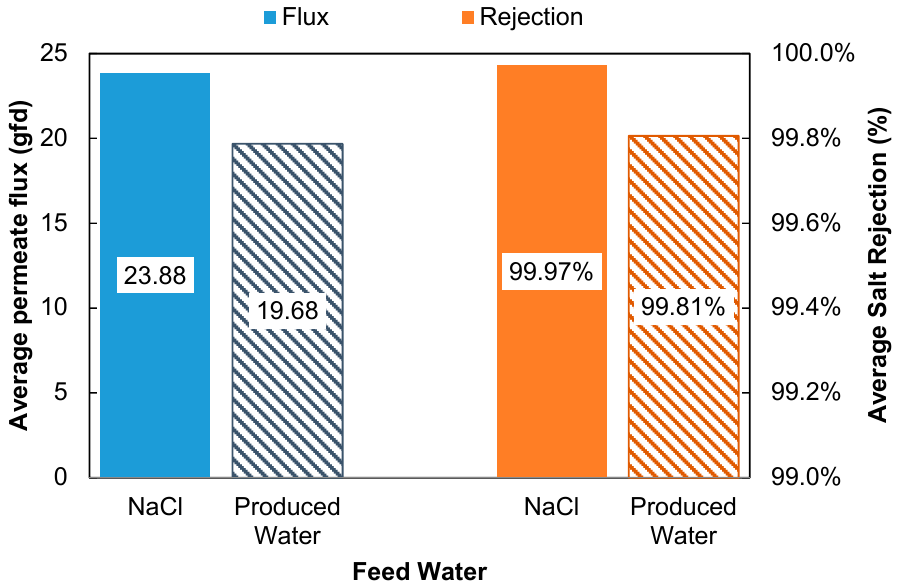
Figure 8. Comparison of system performance when desalinating 10g / L NaCl solution and synthetic producedwater(TDS = 10g /